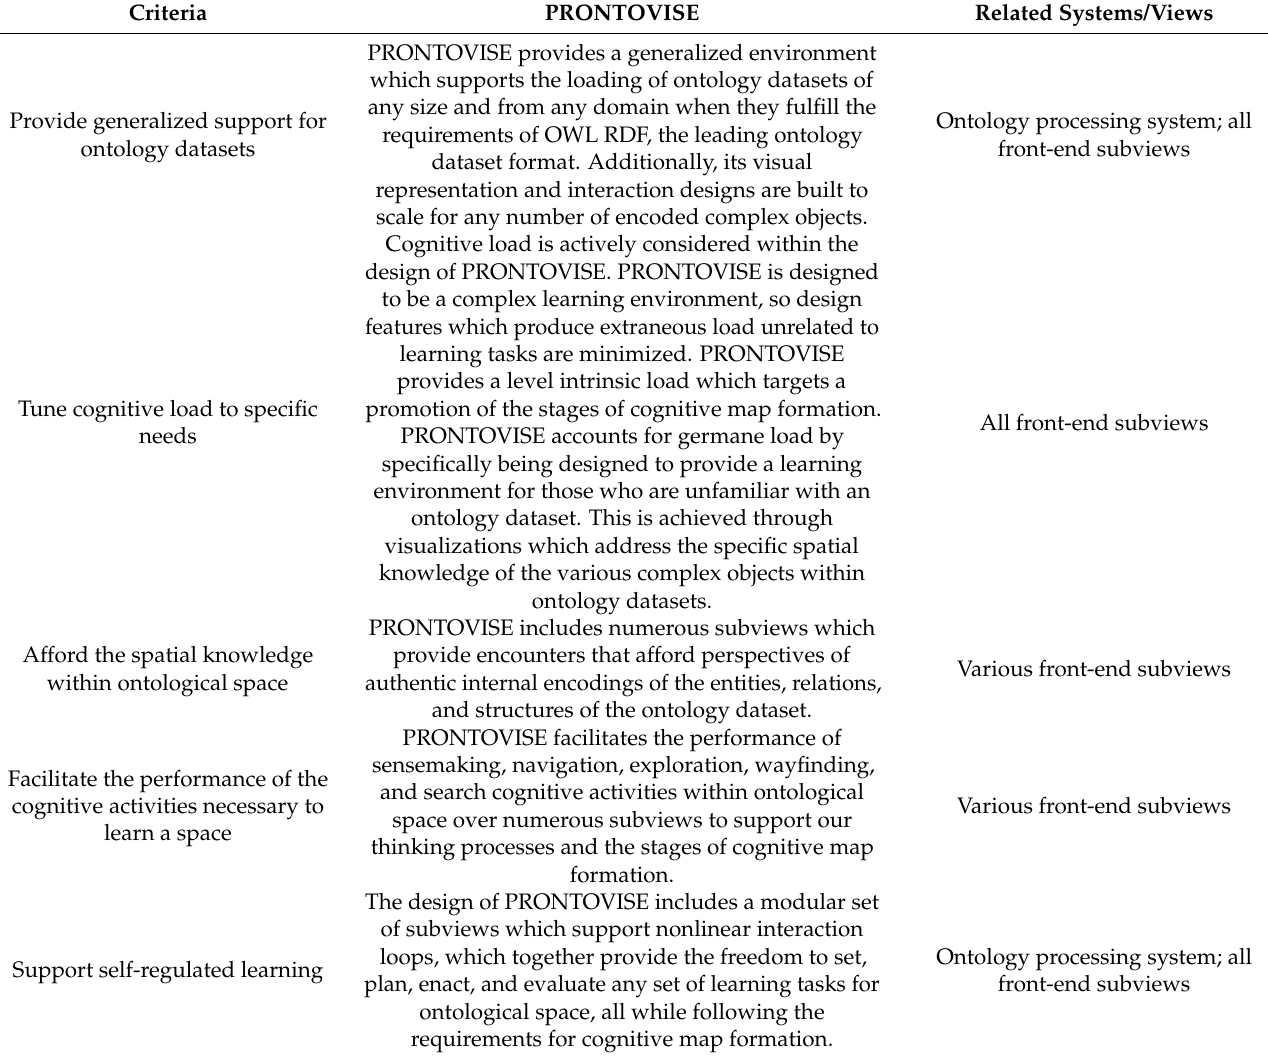
Table 4. A summary of the high-level criteria within PRONTOVISE, which can be used for designing interactive visualization tools which support complex learning and the stages of cognitive map formation. The satisfaction of these criteria at the implementation level are discussed in detail later within the workflow.